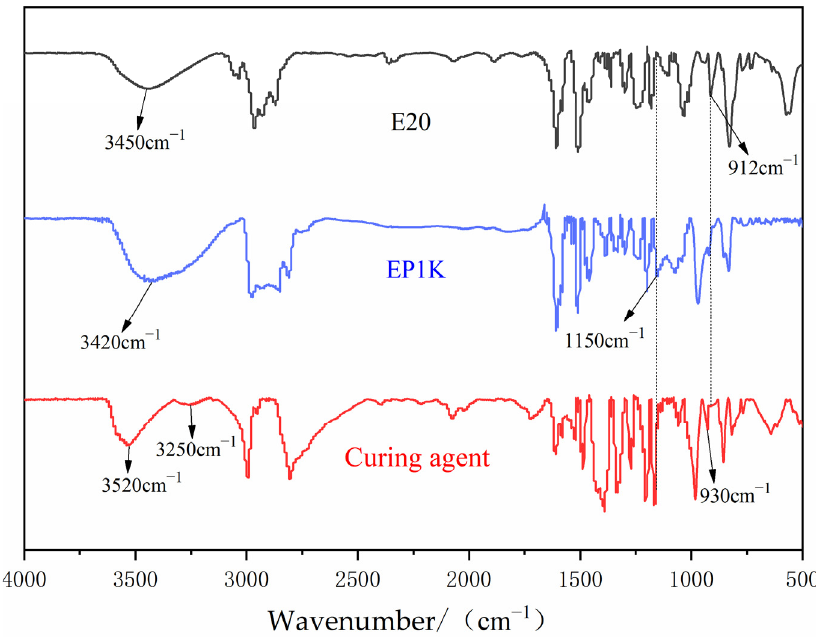
Figure 3. IR spectrum diagram of E20, EP, and self ‐ made waterborne epoxy curing agent.